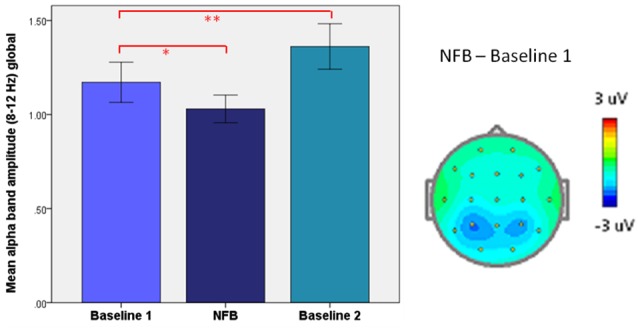
Homeostatic “rebound” following desynchronizing neurofeedback (NFB). Left: mean (±SEM) global alpha amplitude in PTSD patients: before (Baseline 1), during (Neurofeedback), and right after neurofeedback (Baseline 2). Right: Topographic plot of mean alpha amplitude change during neurofeedback (NFB), relative to resting-state (Baseline 1). *p < 0.05, ** P < 0.005. From Kluetsch et al. (2014).